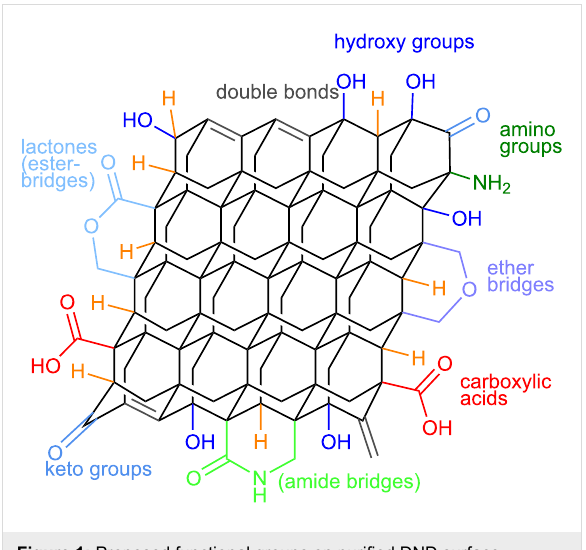
Figure 1: Proposed functional groups on purified DND surface.